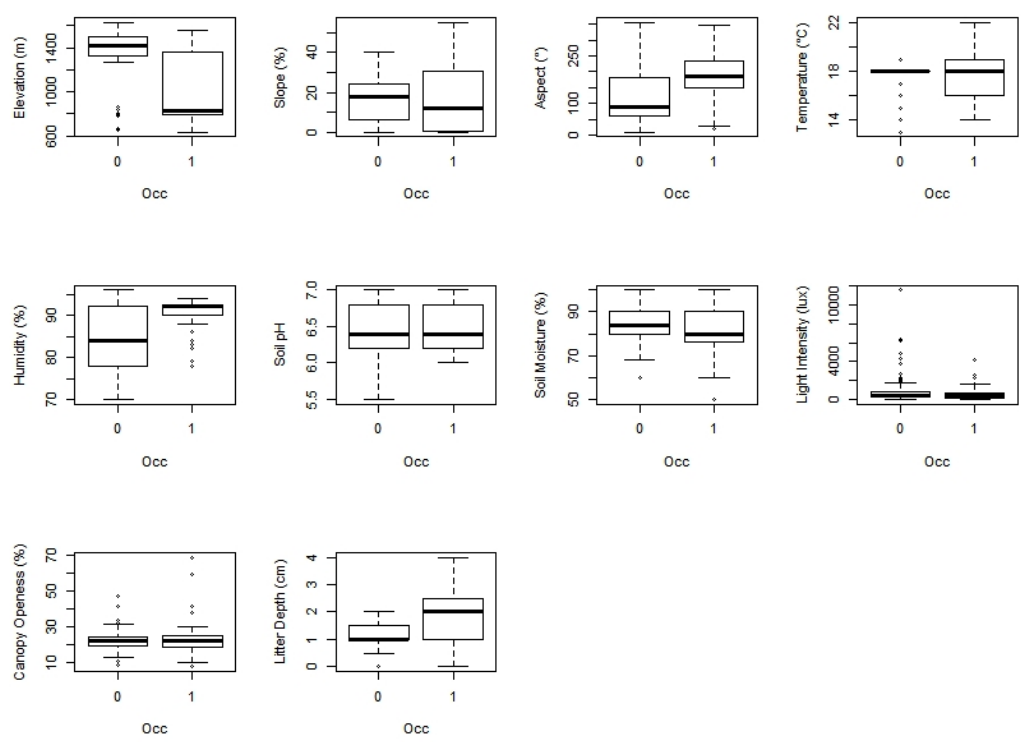
Figure 6. Ten environmental variables in predicting of P. arinasae occurrence. 0 represents an absence location and 1 represents a presence location.